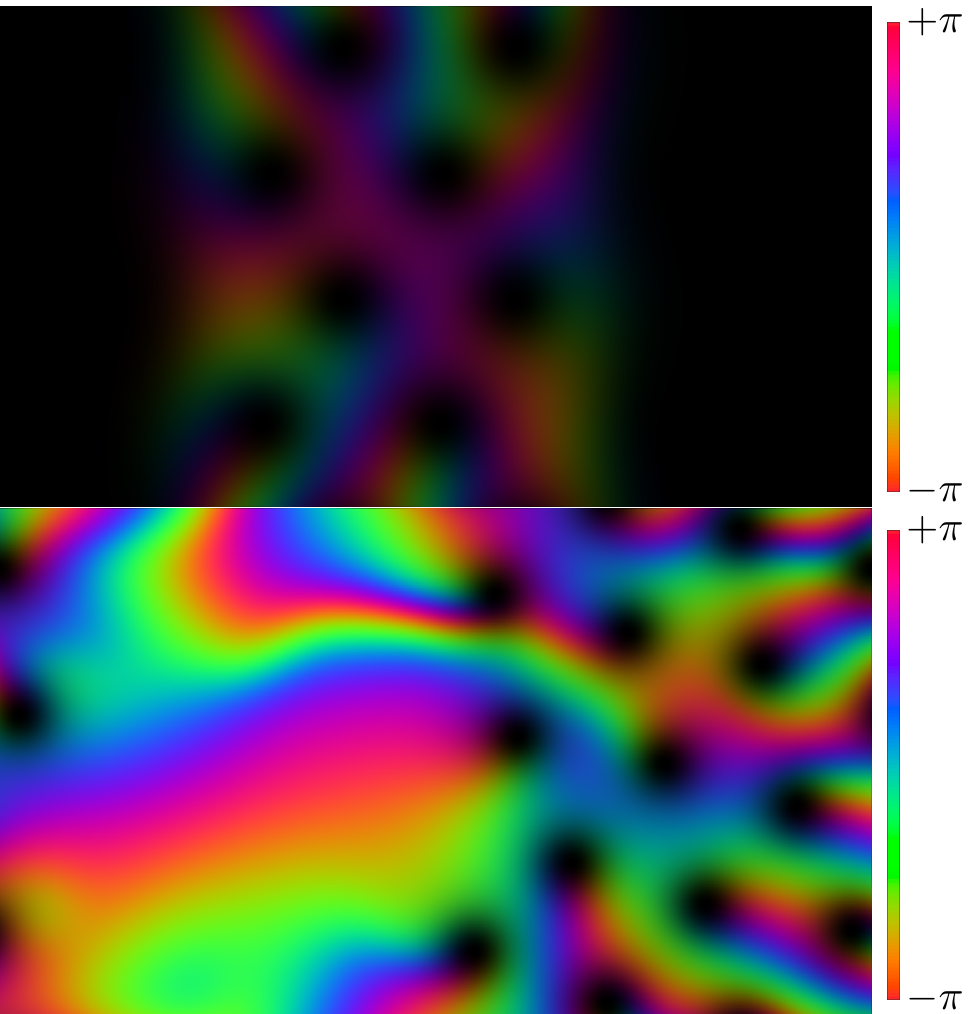
Figure 4. Inhomogeneous ground states for the parameters indicated by red dots in Figure 2. The brightness and hue indicate the density and phase of the proton order parameter, ψ p , respectively. As indicated by the color bar, the phase winds by 2 π around each fluxtube. The first panel shows a case with N = 24 magnetic flux quanta, and a (dimensionless) area of aN = 14.5 to a mixture of non-superconducting protons and hexagonal fluxtube lattice. Approximately 2/3 of the magnetic flux is contained in the non-superconducting domain, visible as dark bands on both sides of the image, and hence only 8 fluxtubes are visible. The low brightness of the lattice domain indicates the low density of the proton condensate there, i.e., case with N = 14 magnetic flux quanta, and a (dimensionless) area of aN = 52 of Meissner state and hexagonal fluxtube lattice. In both cases the aspect ratio is √ 3, which means that a pure hexagonal lattice is a possible state of the system, but is not the ground